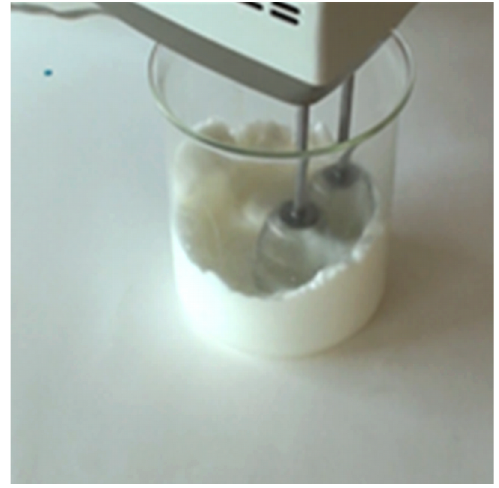
Figure 8. Mixed the egg whites with the hand